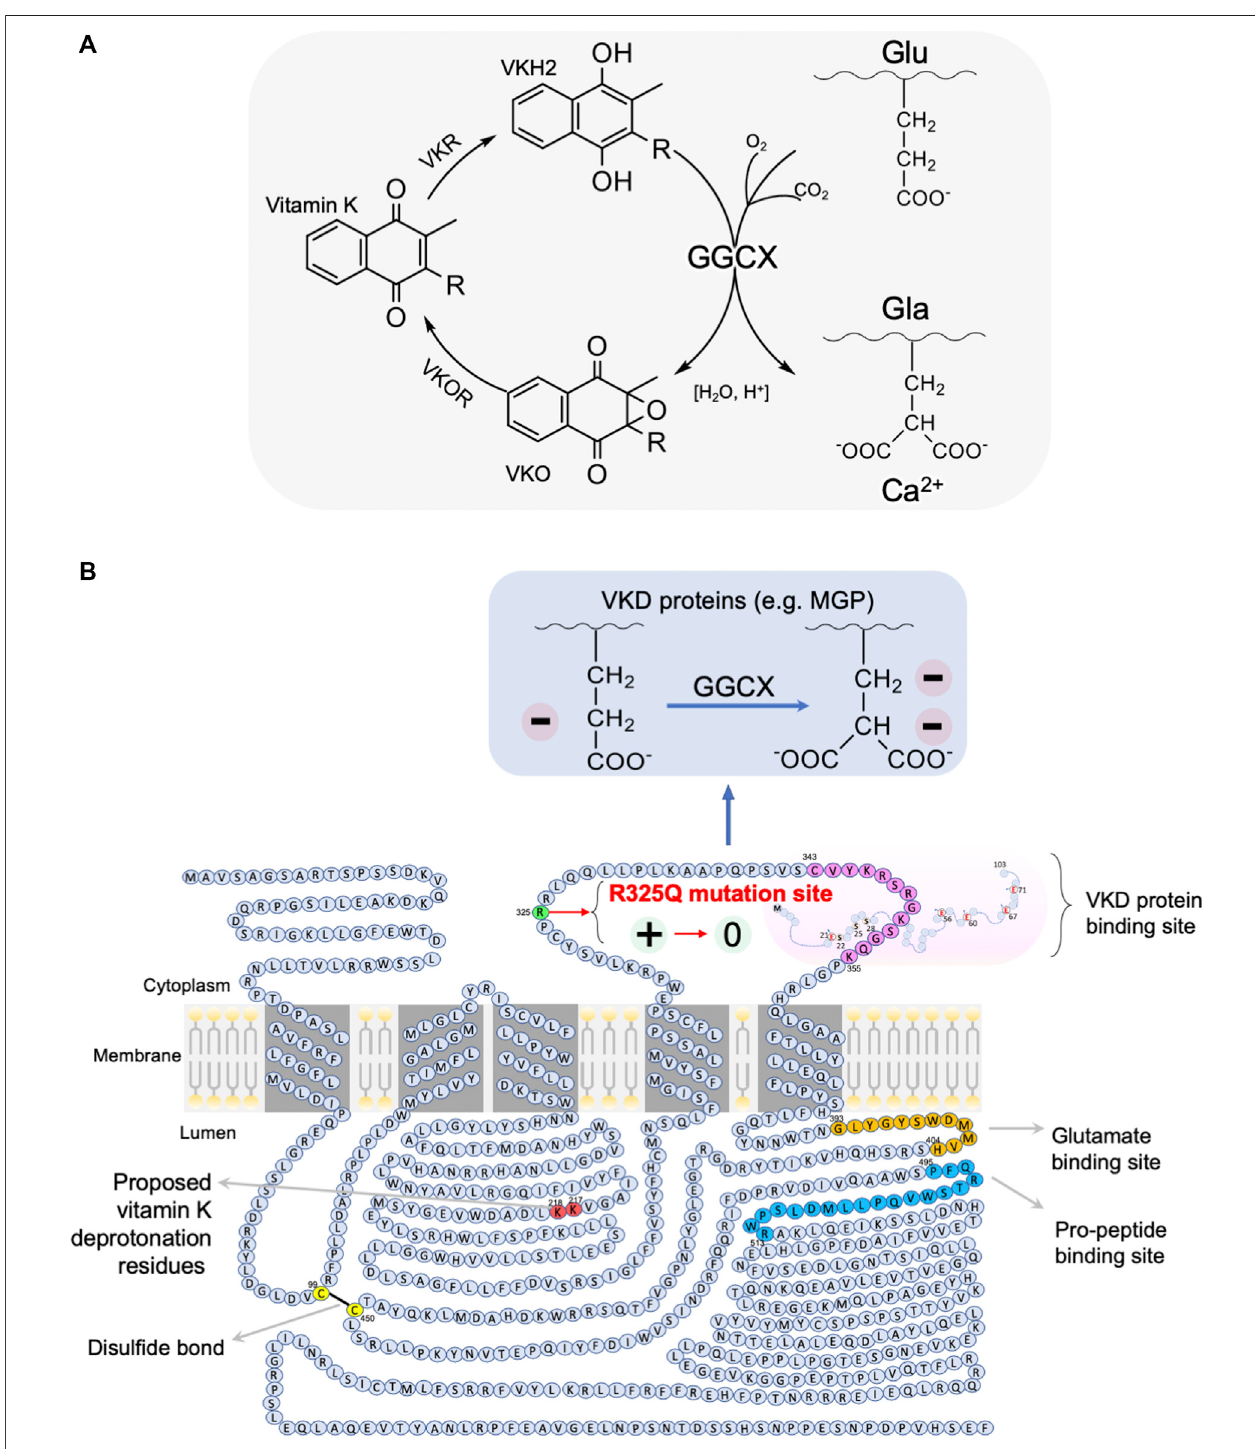
FIGURE 5 | A mechanistic model for the association of the GGCX arginine 325 to glutamine 325 (R325Q) SNP with asthenozoospermia infertility risk in men. (A) Vitamin K cycle: during vitamin K dependent (VKD) carboxylation, the carboxylase GGCX mediates the pH-dependent conversion of glutamate (Glu) residues to Ca 2+ - bindinggamma-carboxyglutamate(Gla)residuesofthevitaminK-dependentsubstrates(e.g.,MGP)ortheirpro-peptides,withCO 2 ,O 2 andreducedvitaminKastheco- substrates.ThecarboxylationreactionalsooxidisesthereducedvitaminK-H2tovitaminKepoxide(VKO),whichisthenreducedbacktovitaminK-H2byvitaminK epoxidereductase(VKOR).Thecycleinvolvesredox-andpH-sensitivecarboxylationandoxygenationprocesses(RishavyandBerkner,2012). (B) GGCXisamembrane protein with a size of ~87.5 kDa, which has two intracellular loops and two luminal loops of amino acid sequences, in addition to its cytoplasmic N-terminus and a long